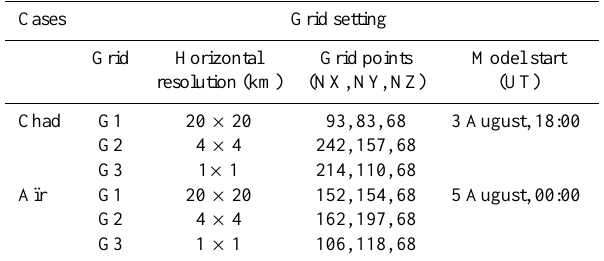
Table 1. Time evolution of the overshoot size in MSG pixels for the A¨ır case, from 14:45UT to 17:30UT. At each time, the maximum BTD is also reported. BTD: Brightness Temperature Difference be- tween the 6.2µm and the 10.8µm channels.